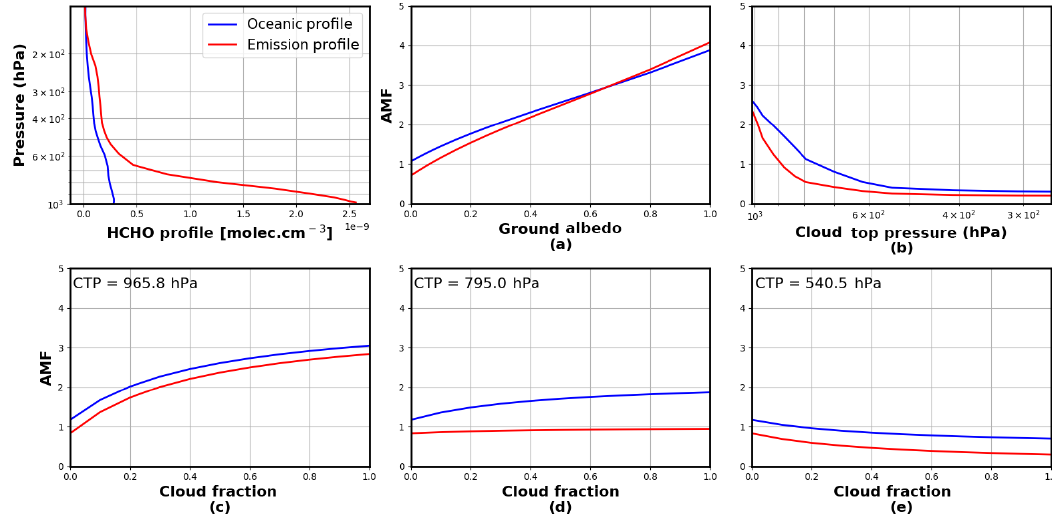
Figure 9. First panel: TM5-MP HCHO profiles extracted in June over the equatorial Pacific ocean (blue) and over Beijing (red). Those profiles have been used to calculated the tropospheric air mass factors shown in the panels (a–e) , representing the AMF dependence on (a) the surface albedo, (b) the cloud altitude, and (c–e) the cloud fraction. In all cases, we consider a nadir view and a solar zenith angle of 30 ◦ . In panel (a) the pixel is cloud-free, in panel (b) the albedo is 0.02 and the effective cloud fraction is 0.5, and in panels (c–e) the ground albedo is 0.02 and the cloud pressure is, respectively, 966, 795, and 540hPa.